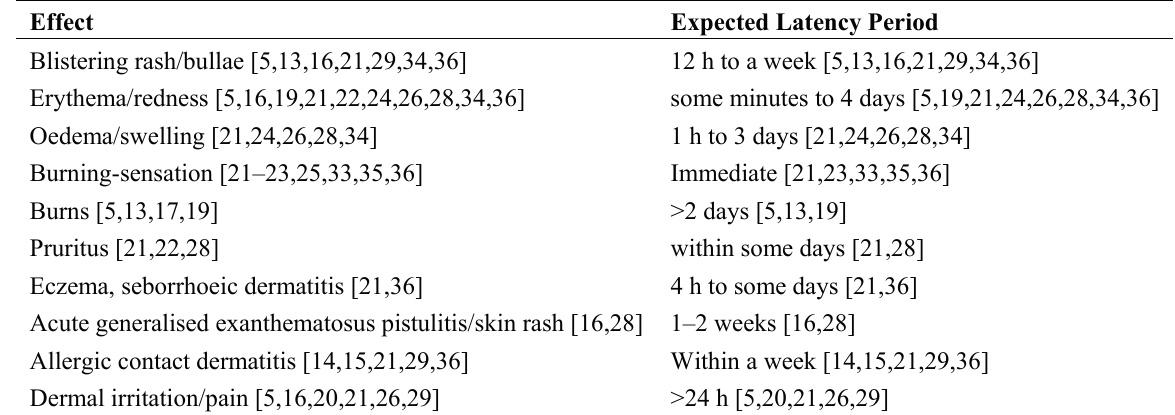
Table 3. Dermal clinical effects and latency